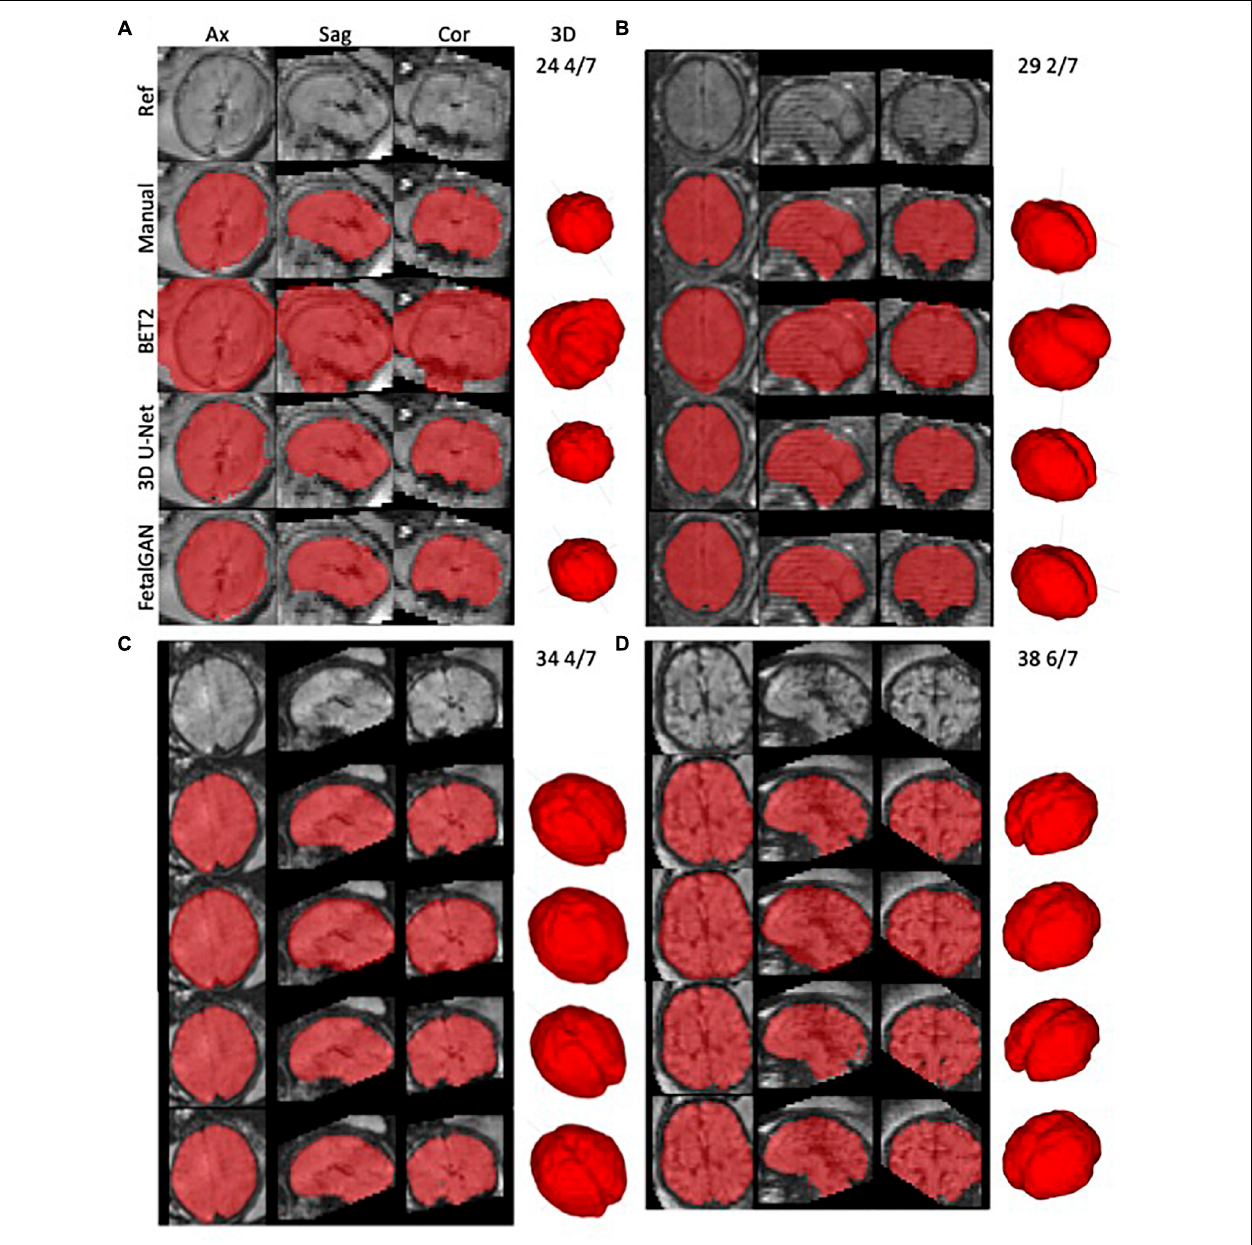
FIGURE 2 | Representative whole brain masks from manual segmentation, BET2, 3D U-Net, and FetalGAN. Manual corrections were done using ITK-SNAP. FetalGAN produced the most accurate segmentation relative to the ground truth with an average Dice score of 0.942 ± 0.095. (A) 25 4/7 weeks, (B) 29 2/7 weeks, (C) 34 4/7 weeks, and (D) 38 6/7